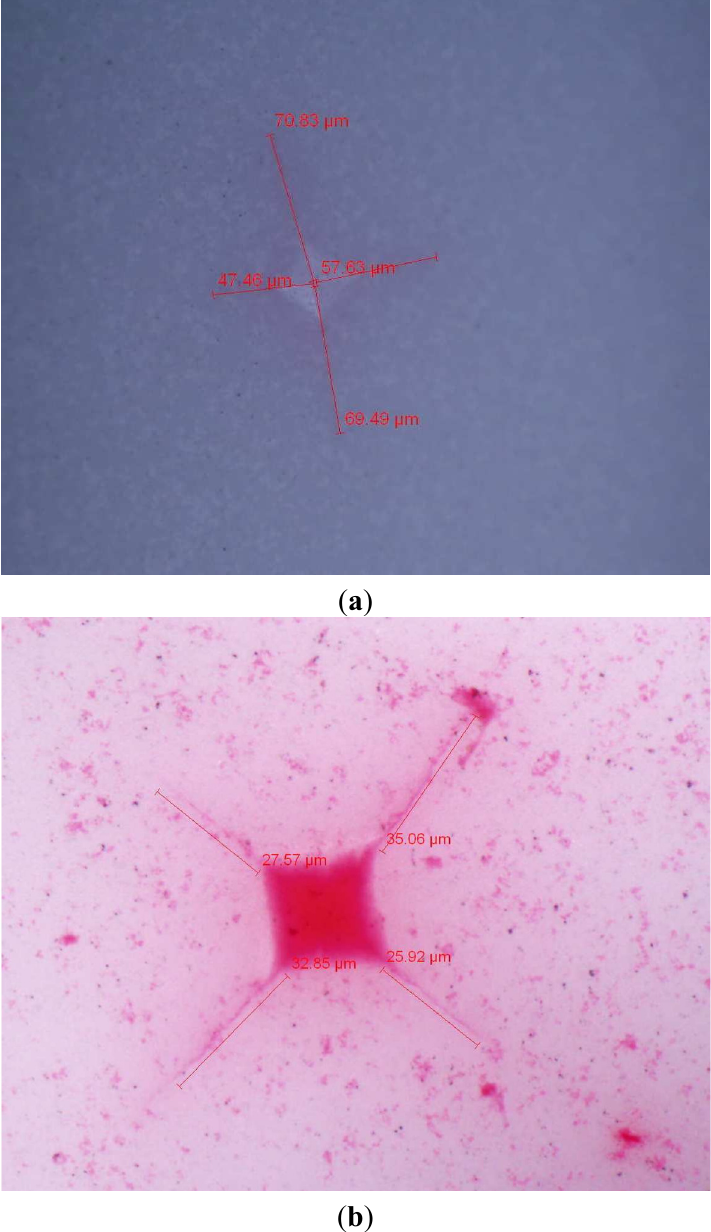
Figure 8. Optical micrograph of Vickers hardness indentation on ZTA surfaces conducted: ( a ) without colouring; ( b ) with red surface